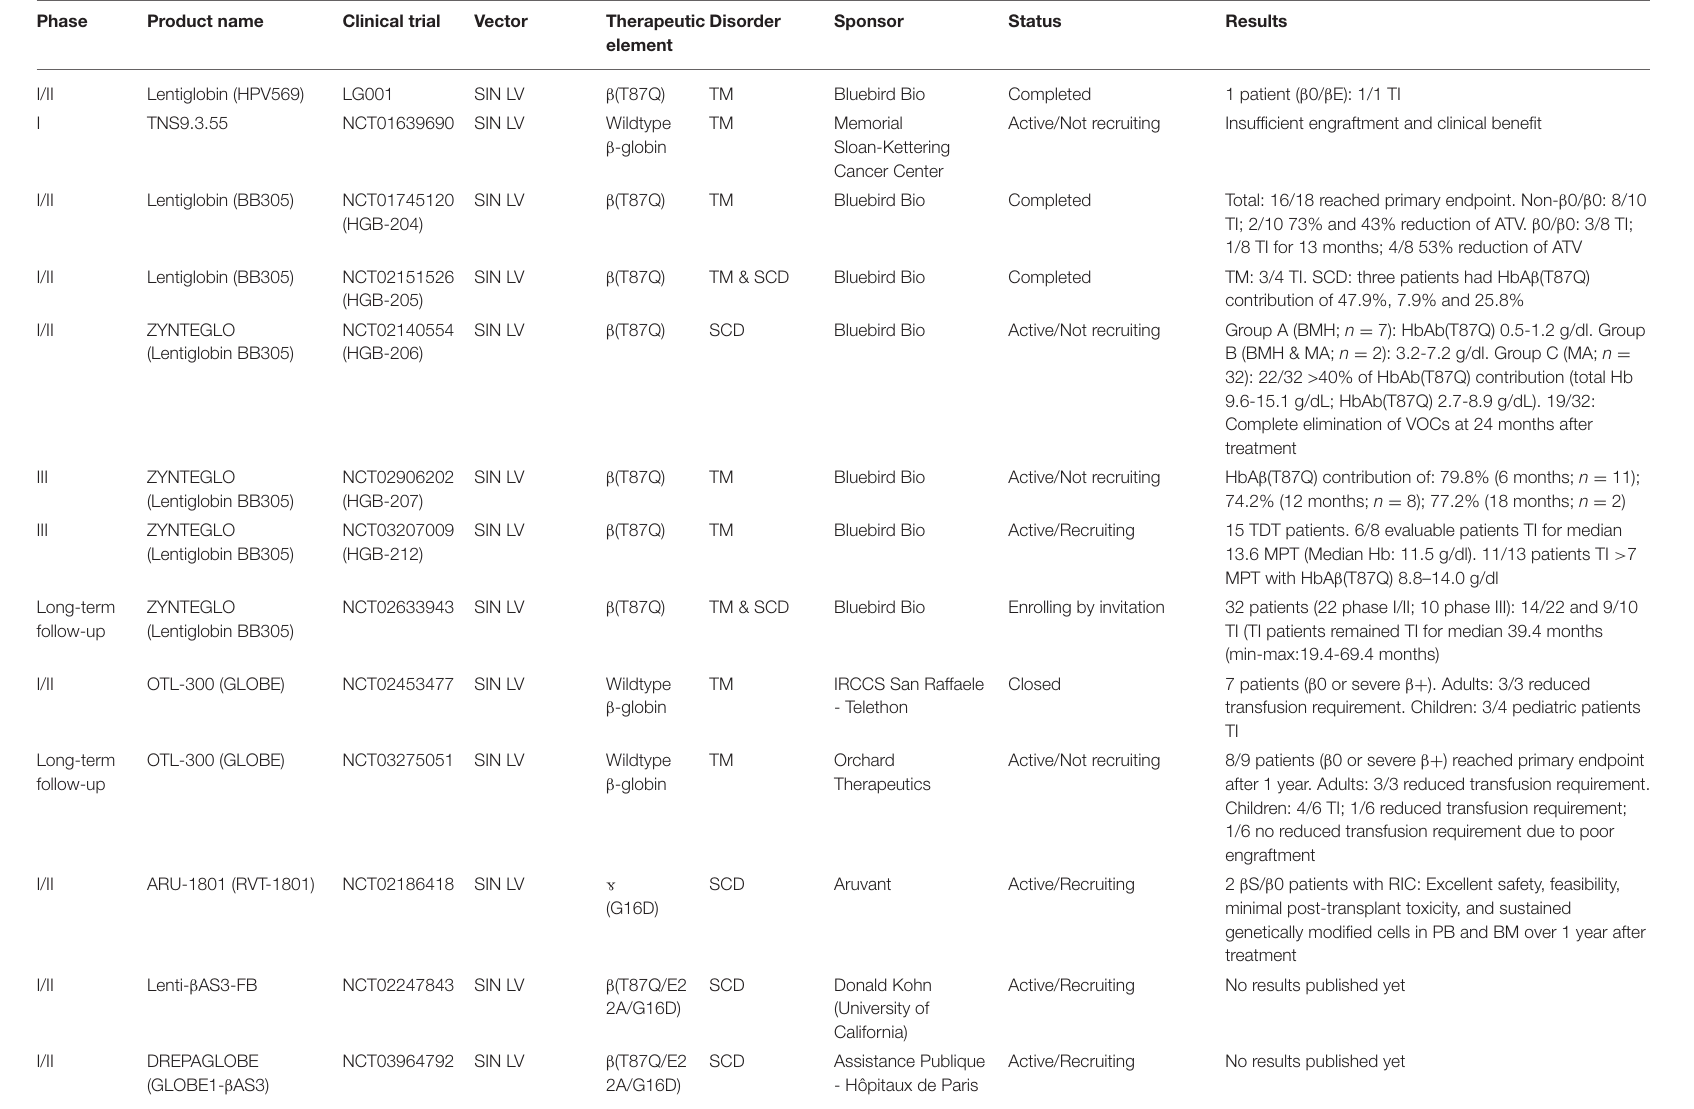
TABLE 1 | Genetic therapies in development based on SIN LVs.